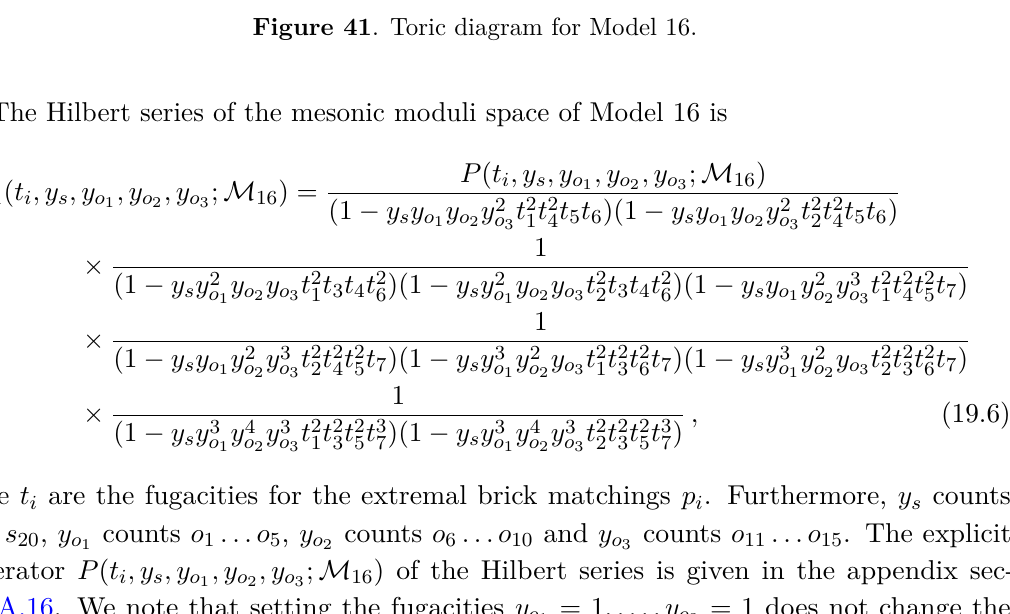
Figure 41 . Toric diagram for Model